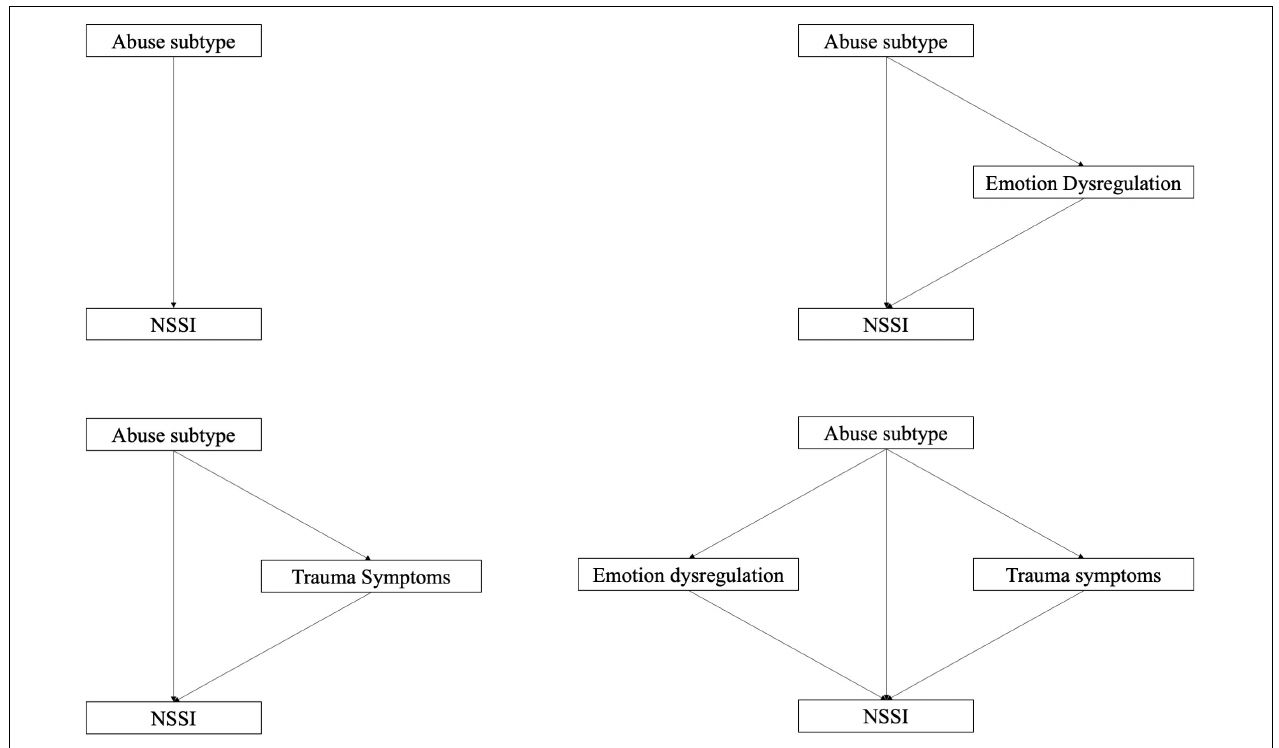
FIGURE 1 | Models 1a–d: Modeling direct effect, single and parallel mediation.